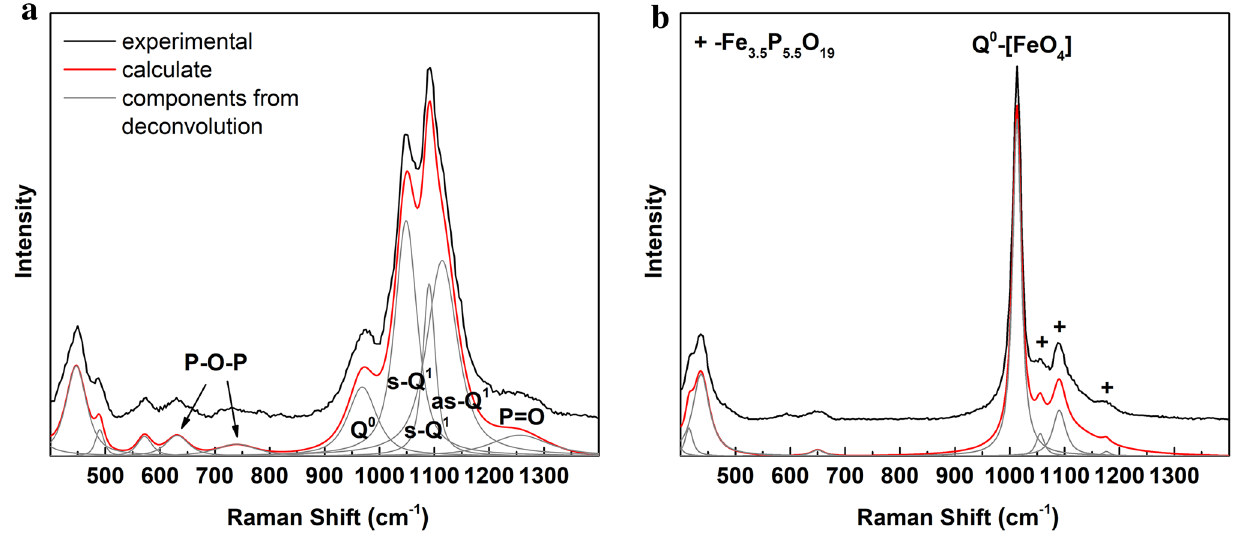
Figure 4. Raman spectra and their deconvolution of (a) Fe 7 P 11 O 38 and (b) FePO 4 dominating phases.